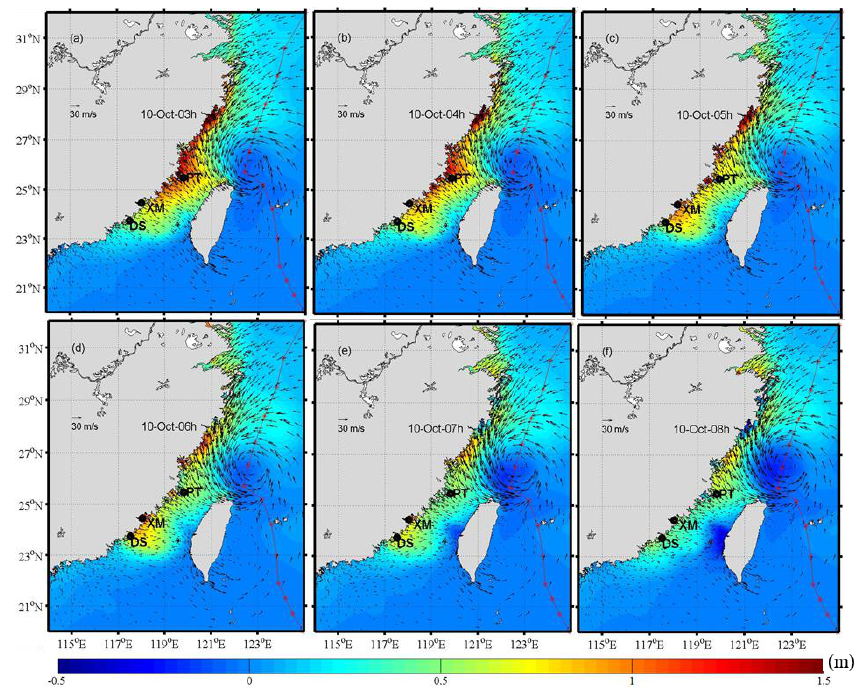
Figure 10. ( a – f ) show temporal change of the model non-tidal sea surface height anomalies and the forcing wind fields at 03:00, 04:00, 05:00, 06:00, 07:00 and 08:00 on 10 October. The model run is forced by both the tide and the NCEP wind modified by 1.3-times.